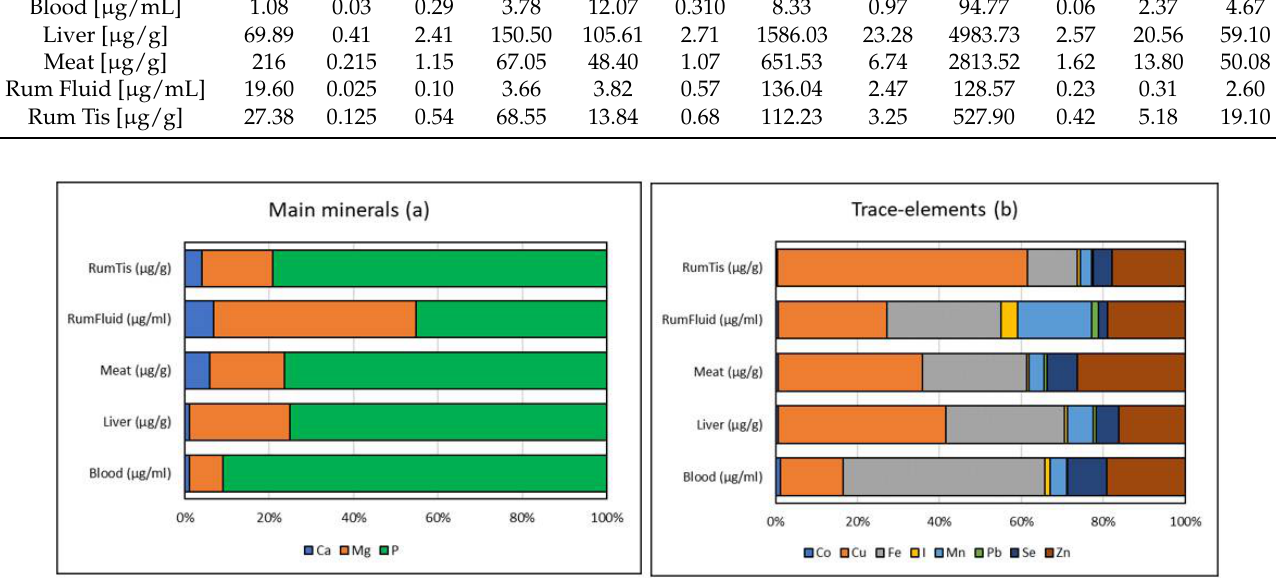
Figure 3. Proportion [in %] of different main minerals ( a ) and trace elements ( b ) in whole blood and organs of camel collected in five Saudi Arabian regions and at two seasons.